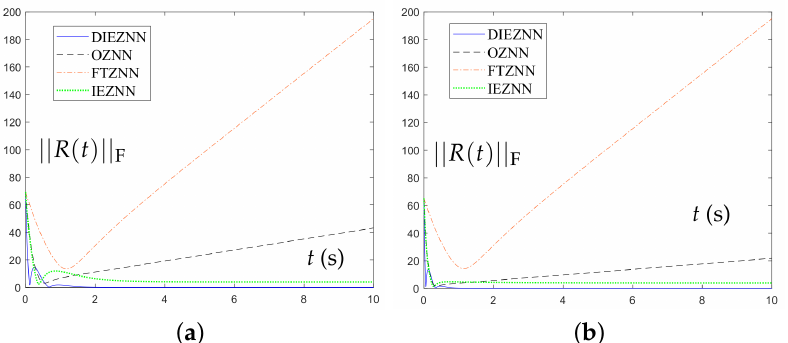
Figure 2. The error function norm (cid:107) R ( t ) (cid:107) F of the DIEZNN model (Equation (14)), OZNN model (Equation (5)), FTZNN model (Equation (8)) and IEZNN model (Equation (11)) for solving Equa- tion (1) under linear noise 10 + 10 t . The error function norms (cid:107) R ( t ) (cid:107) F of the DIEZNN model (Equation (14)), the OZNN model (Equation (5)), FTZNN model (Equation (8)) and IEZNN model (Equation (11)) are represented by blue solid curves, black dashed curves, orange dash-dotted curves and green dotted curves, respectively. ( a ) Design parameters γ = 5. ( b ) Design parameter γ =